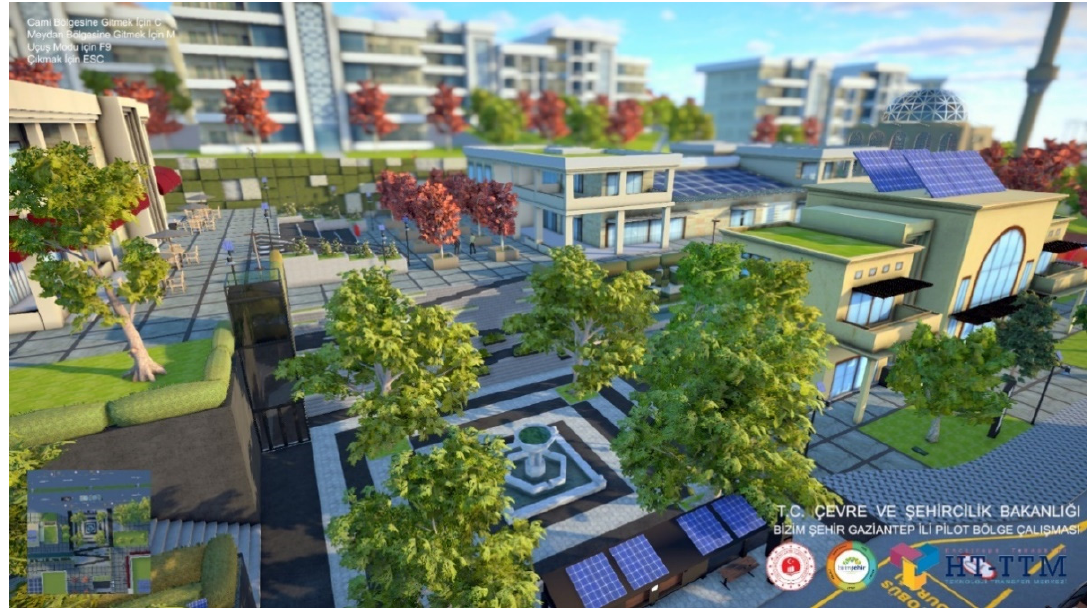
Figure 21. Unity simulation of the LoD3 future city model generated in the study.